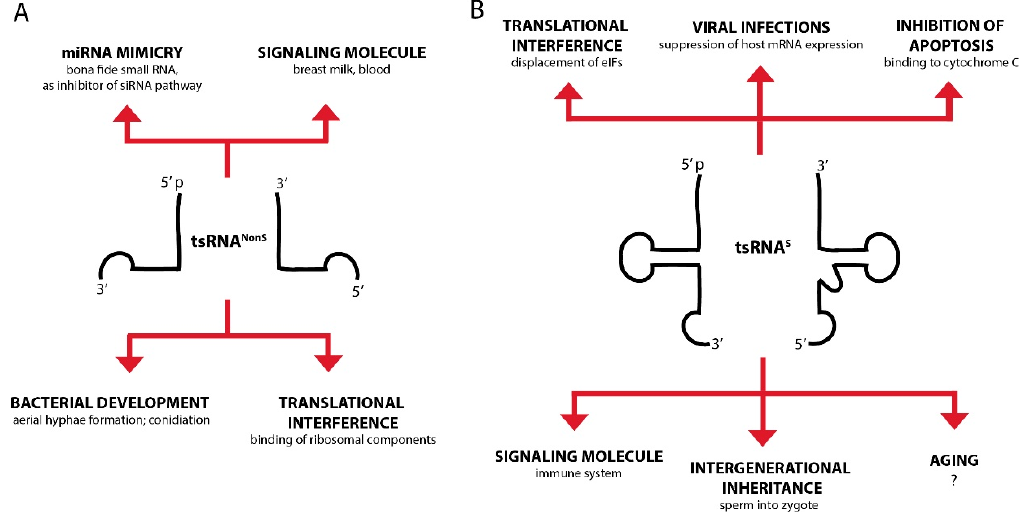
Figure 3. The activity of tsRNAs has been implicated in various biological processes. A selection of reported and suggested functions for tsRNAs NonS ( A ) and tsRNAs S ( B ) in different model organisms.